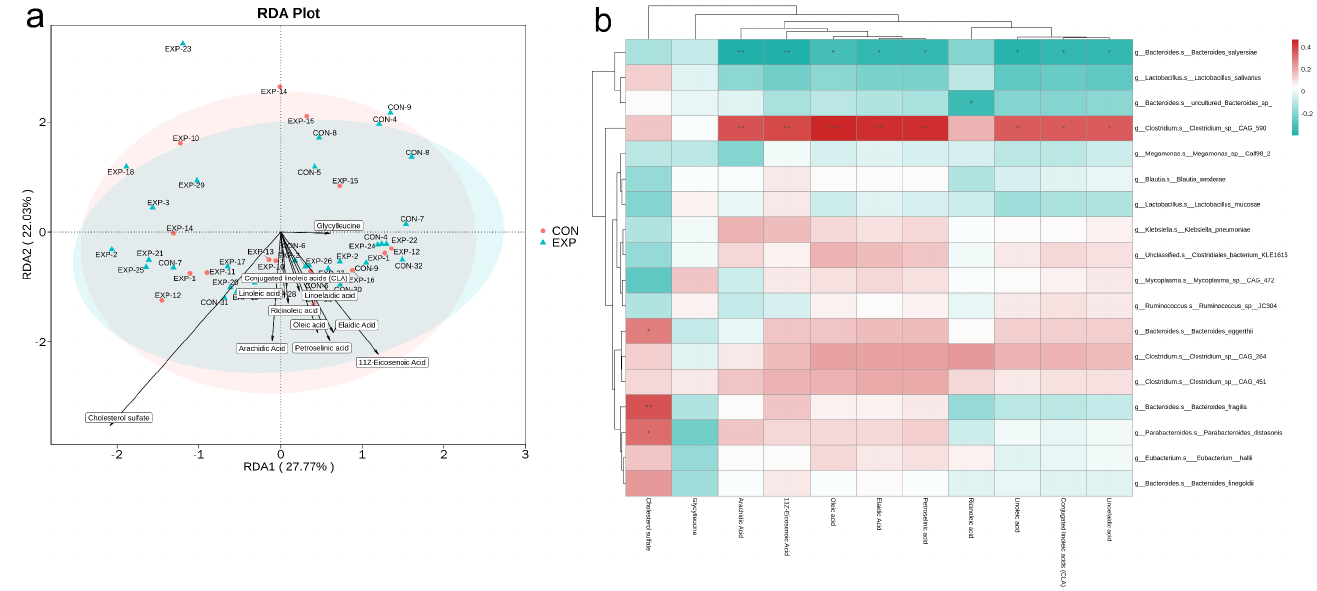
Figure 7. Integrative analysis of metagenomics and metabolomics (BLCA patients, EXP group; healthy individuals, CON group). ( a ) Redundancy analysis (RDA) at the species level. Dots of different colors or shapes indicate different samples. Arrows indicate metabolite information. A projection was made from the point to the arrow of the metabolite, and the distance of the projection point from the origin represents the relative influence of the metabolite on the distribution of the sample community. ( b ) Heat map of correlation coefficients between significantly different microbiomes and metabolites in two groups. Each row indicates a microbiome at the species level. Each column indicates a significantly different metabolite. The correlation coefficient R is expressed in color. R > 0 indicates positive correlation (red); R < 0 indicates negative correlation (blue). * indicates p -value < 0.05; ** indicates p -value < 0.01; *** indicates p -value < 0.001.